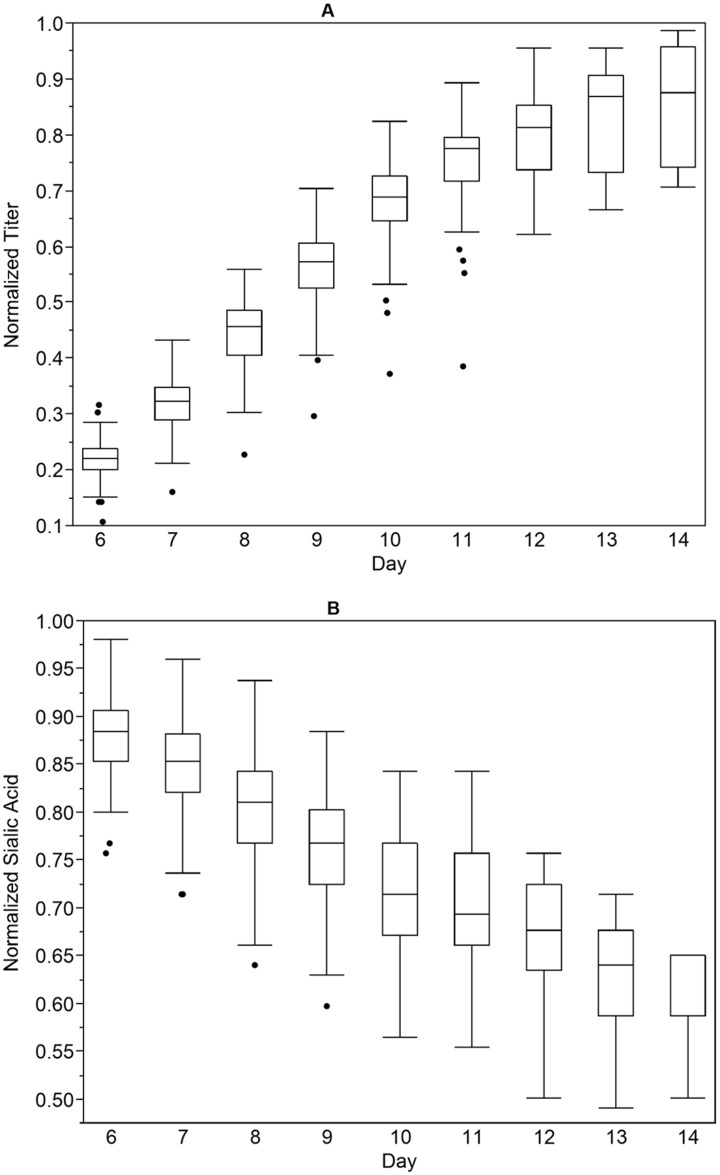
Large Scale Cell Culture Performance.Cell culture performance attributes titer (A) and NANA level (B) are shown over culture duration for 45 bioreactor runs at 50-L, 500-L, 900-L and 5000-L scale. Data was normalized to range from 0 to 1. Median is indicated by the horizontal line, interquartile range by the height of the box, and the full range by the vertical line. Outliers are shown as dots.